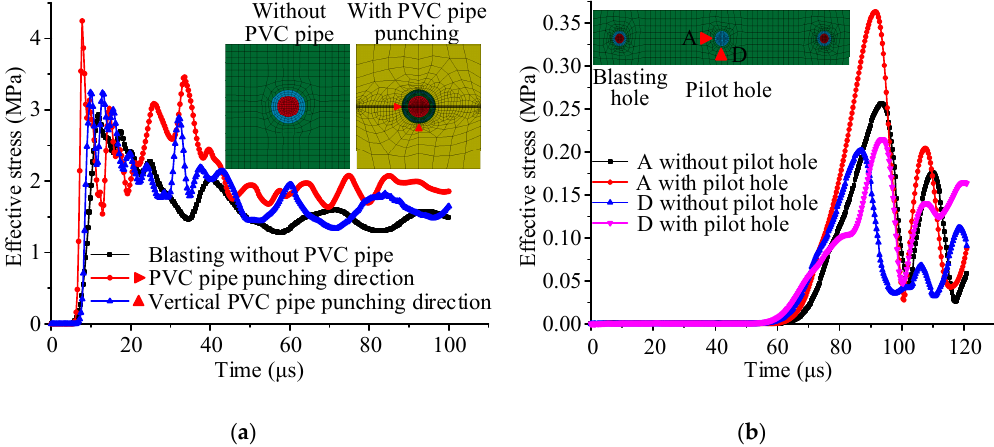
Figure 8. Time–history curve of the blasting hole wall effective stress: ( a ) directional pre-splitting blasting with PVC pipe punching; ( b ) effect of an empty hole on blasting.